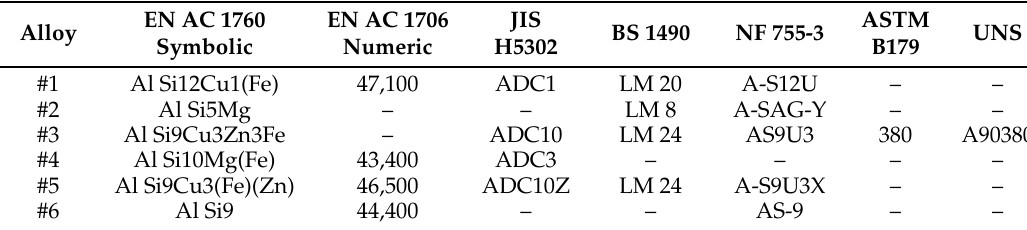
Table 1. Designation and nomenclature of the studied alloys.